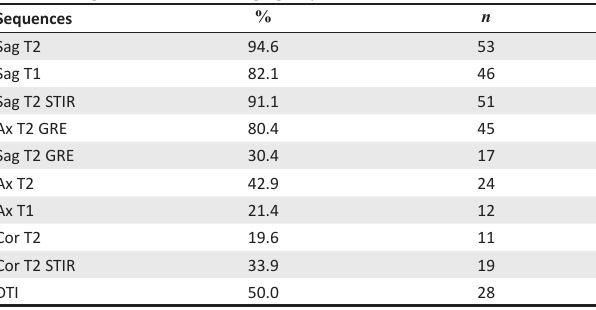
TABLE 2: Magnetic resonance imaging